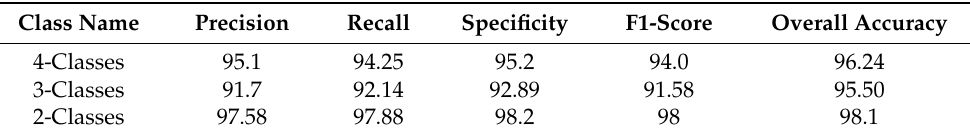
Table 8. Performance of different classes (four-class, three-class, two-class) using the C19D-Net Model.